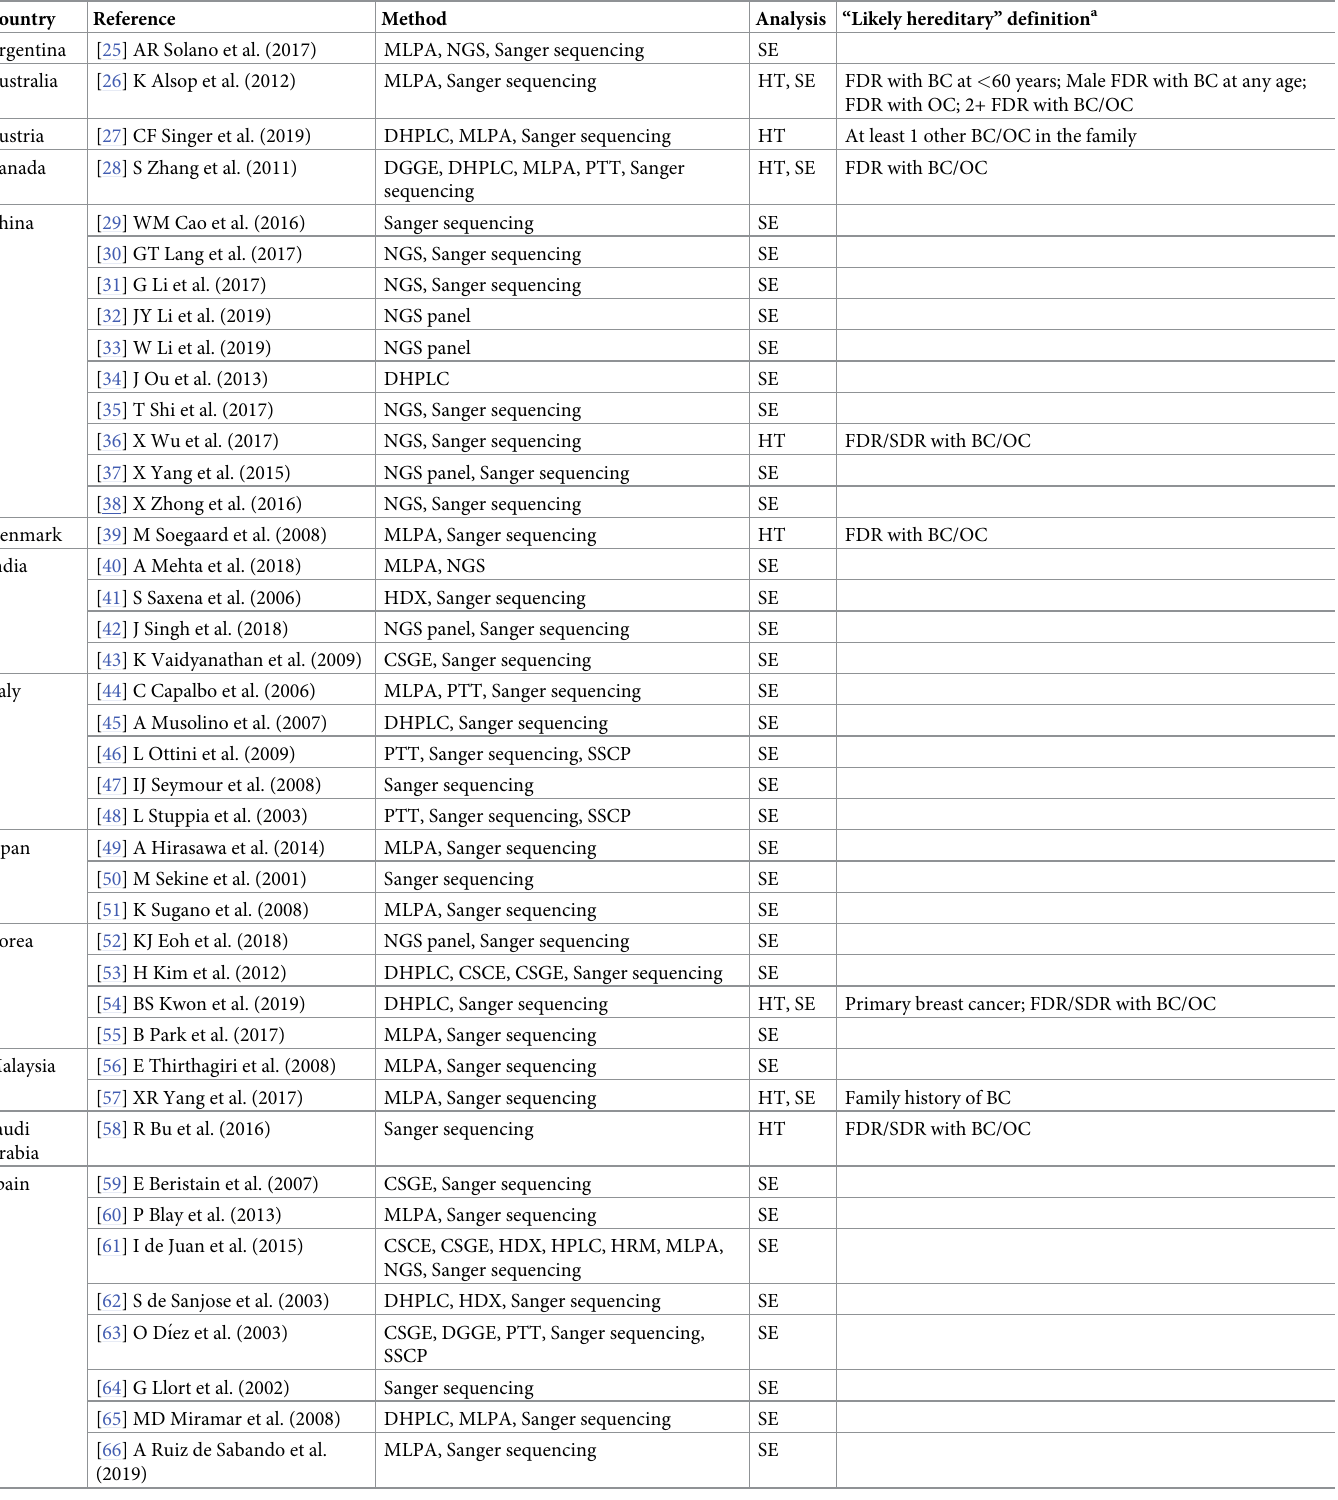
Table 1. Studies included in analyses.